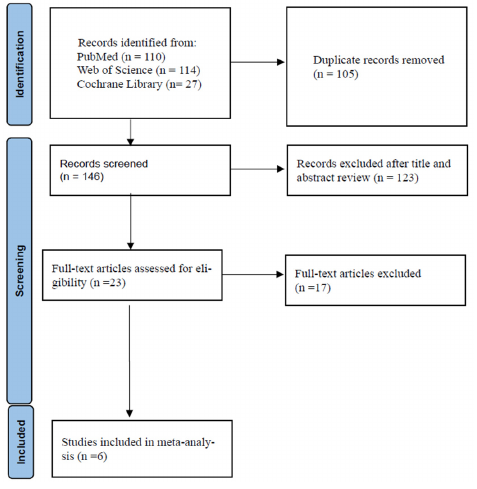
Figure 1: Flow diagram of the study selection process. Figure 1. Flow diagram of the study selection